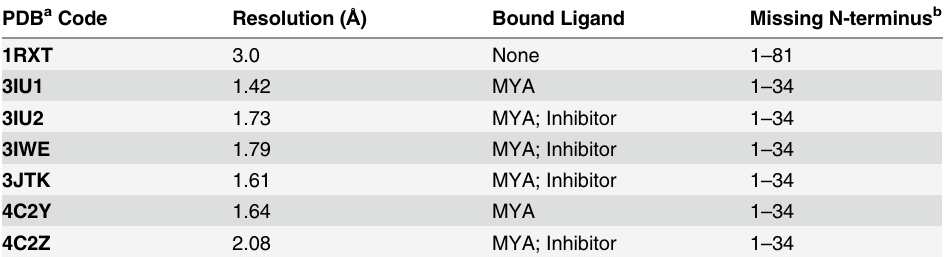
Table 1. List of hNMT1 crystal structures and their features. PDB a